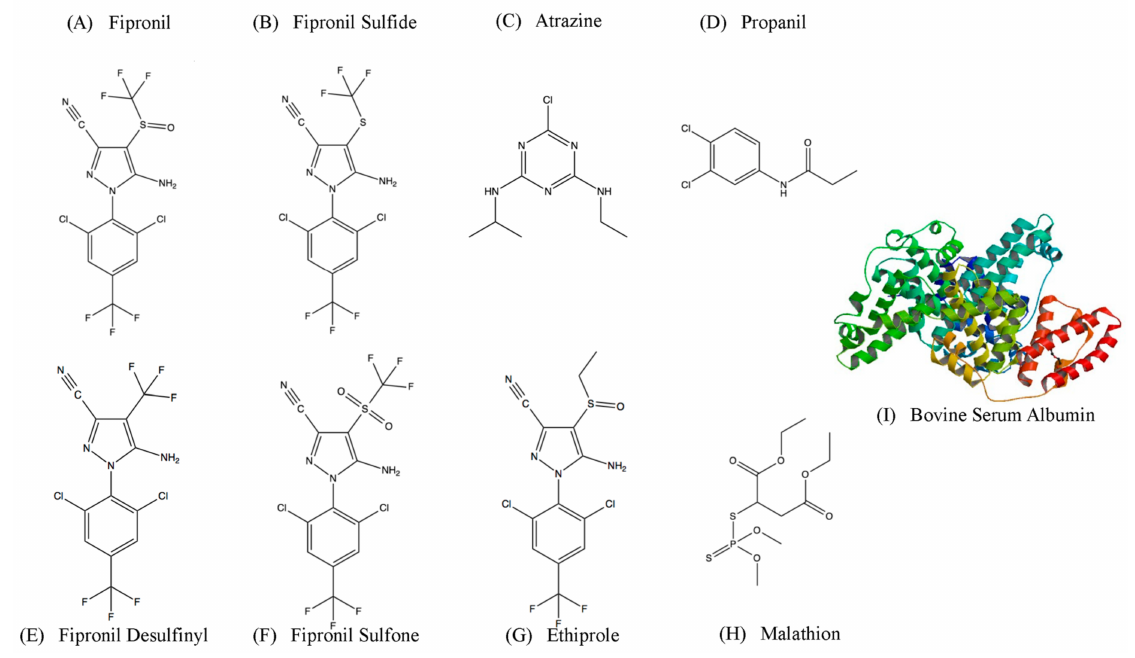
Figure 6. Chemical structures of targets used in the SELEX process and cross-binding assays. ( A ) Structure of the pesticide and target of selection fipronil; ( B , E , F ) Structures of fipronil